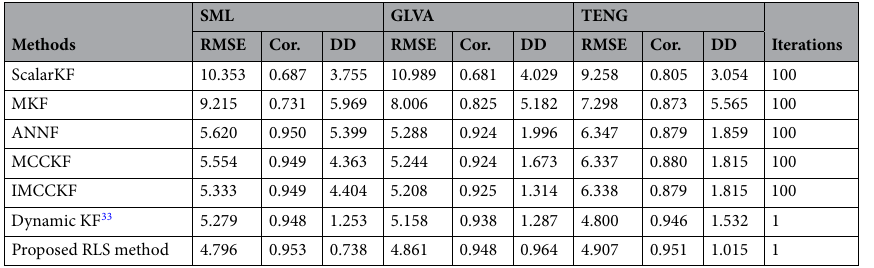
Table 3. Comparison of proposed method with previous methods using SML, GLVA and TENG with Jitter Noise ( σ